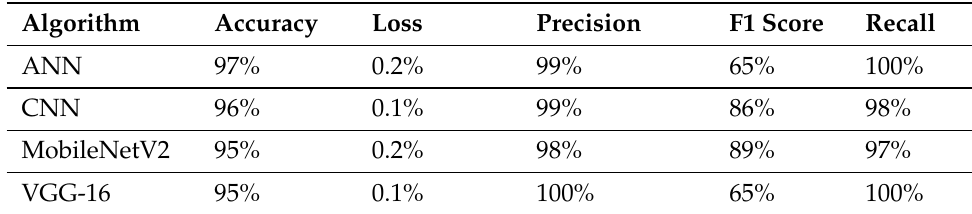
Figure 10. Models ROC curve on nutrient deficiency classification. Table 9. Deficiency